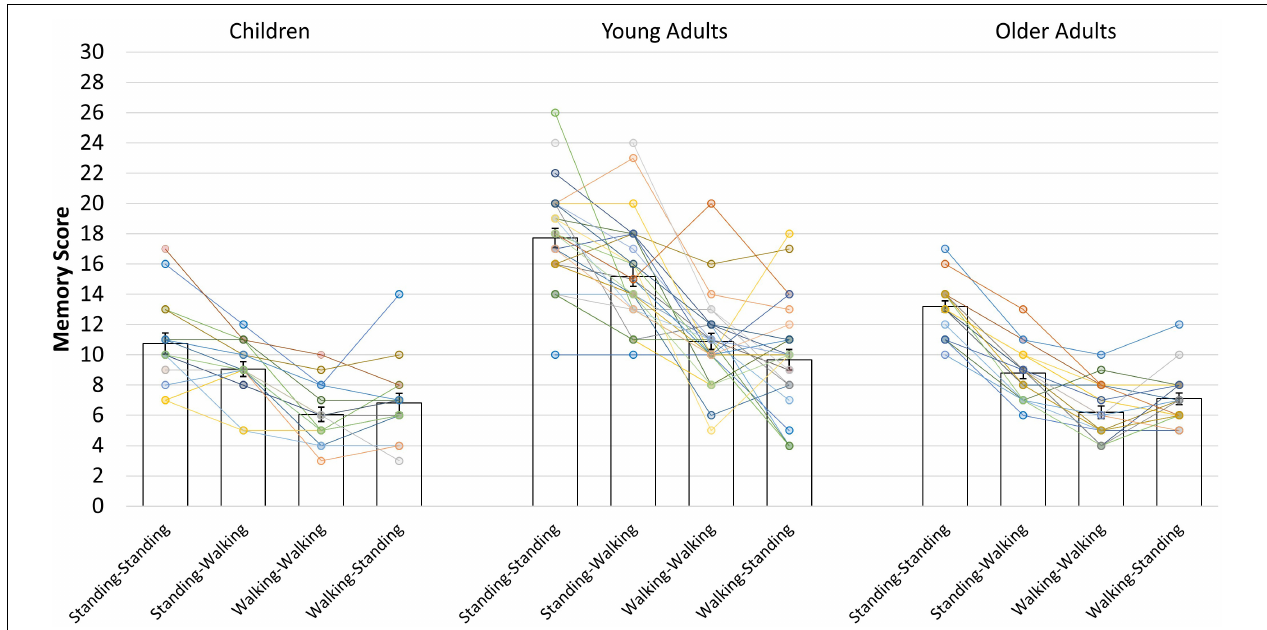
FIGURE 3 | Individual data points of the spatial memory task for the four combinations of encoding and recall conditions in each age group. Bars indicate mean scores with standard error means. Data points connected by lines indicate the performances of single participants in each age group.